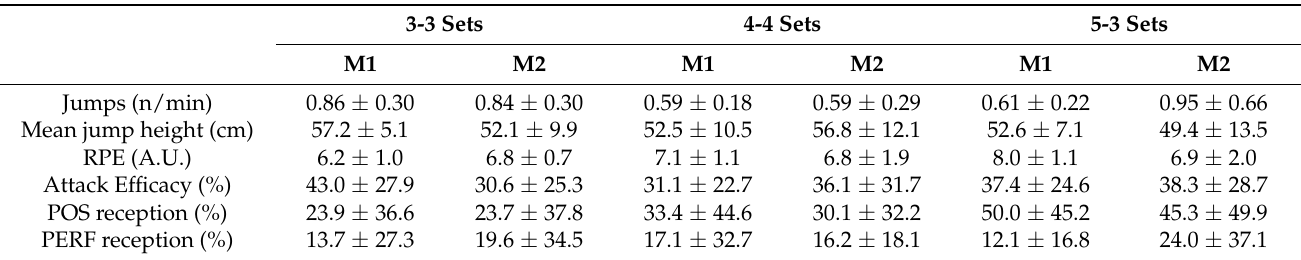
Table 3. Descriptive statistics (mean ± standard deviation) of outcomes between the first and second match considering the number of sets involved.